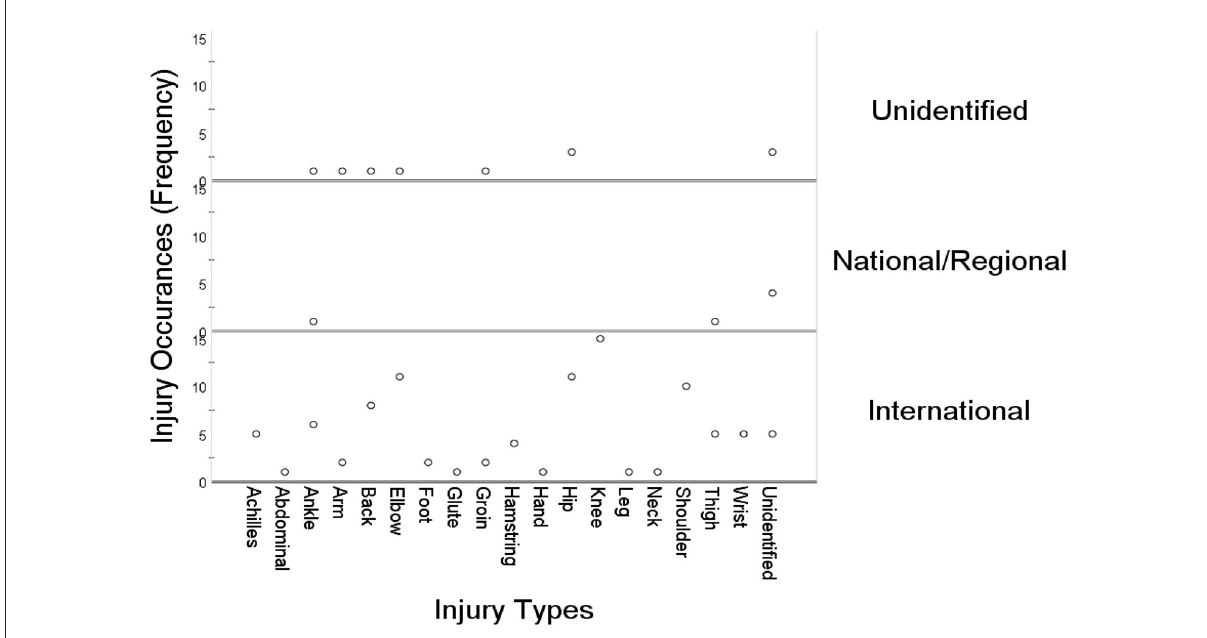
FIGURE4 Types of injury occurrences at different